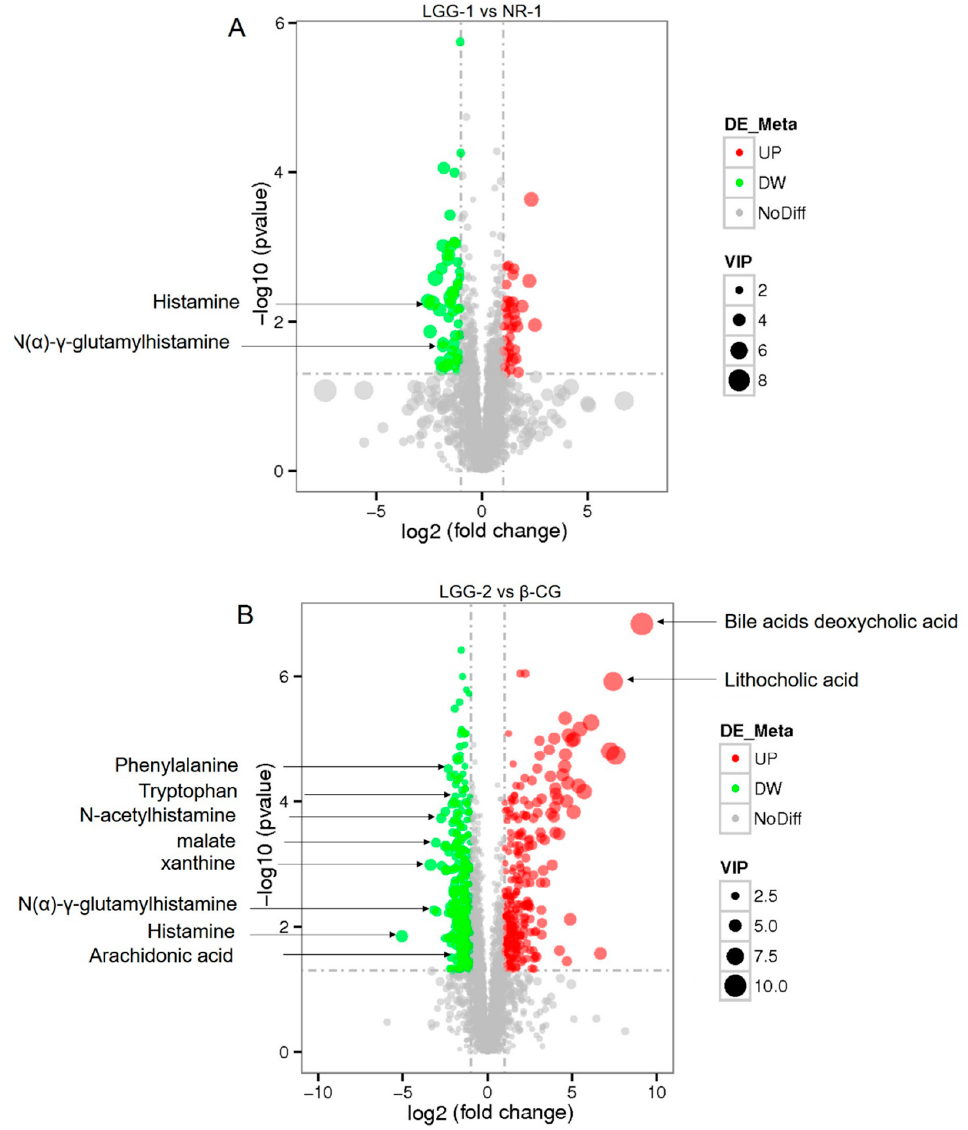
Figure 7. Identification of metabolites in the bile secretion pathway. ( A ) Volcano map of differen- tial metabolites in positive ion mode between the LGG-1 group and the NR-1 group; ( B ) Volcano map of differential metabolites in positive ion mode between the LGG-2 group and the β -CG